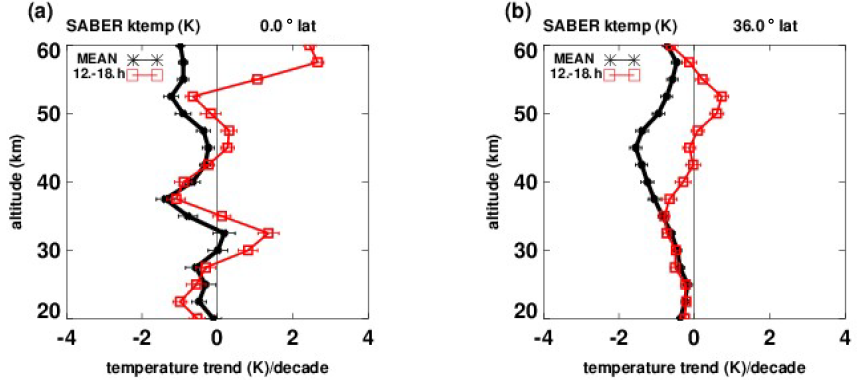
Figure 7. Temperature trends (K per decade) vs. altitude at the Equator (a) and 36 ◦ N latitude (b) . Black lines: trends based on SABER data (averaged over longitude and local time); red squares: estimated trends for cases where local times of measurements increase linearly from 12:00 to 18:00LT from 2002 to